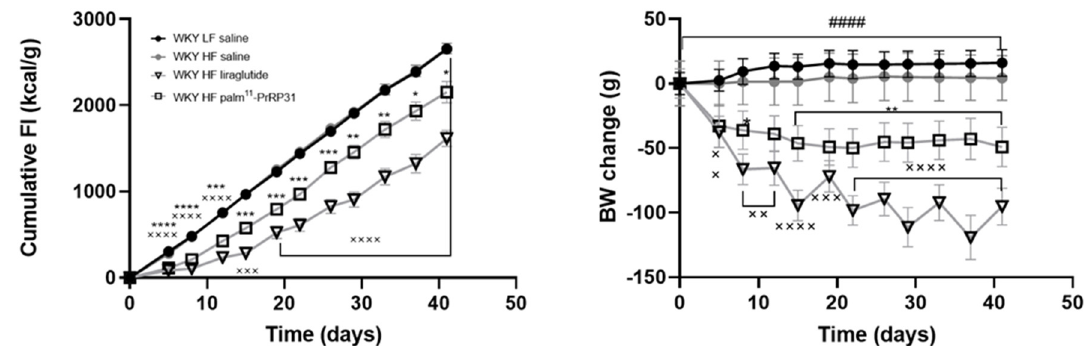
Figure 3. Chronic effect of palm 11 -PrRP31 and liraglutide on cumulative FI and BW change in DIO WKY rats during the treatment (60–66 weeks). Data are presented as means ± S.E.M. Statistical analysis was performed by two-way ANOVA with Bonferroni ´ s post hoc test. BW body weight, FI food intake. Significance is, #### p < 0.0001 WKY HF saline vs. WKY LF saline; × p < 0.05, ×× p < 0.01, ××× p < 0.001, ×××× p < 0.0001 WKY liraglutide vs. WKY HF saline; * p < 0.05, ** p < 0.01, *** p < 0.001, **** p < 0.0001 WKY palm 11 -PrRP31 vs. WKY HF saline (n = 6–8).